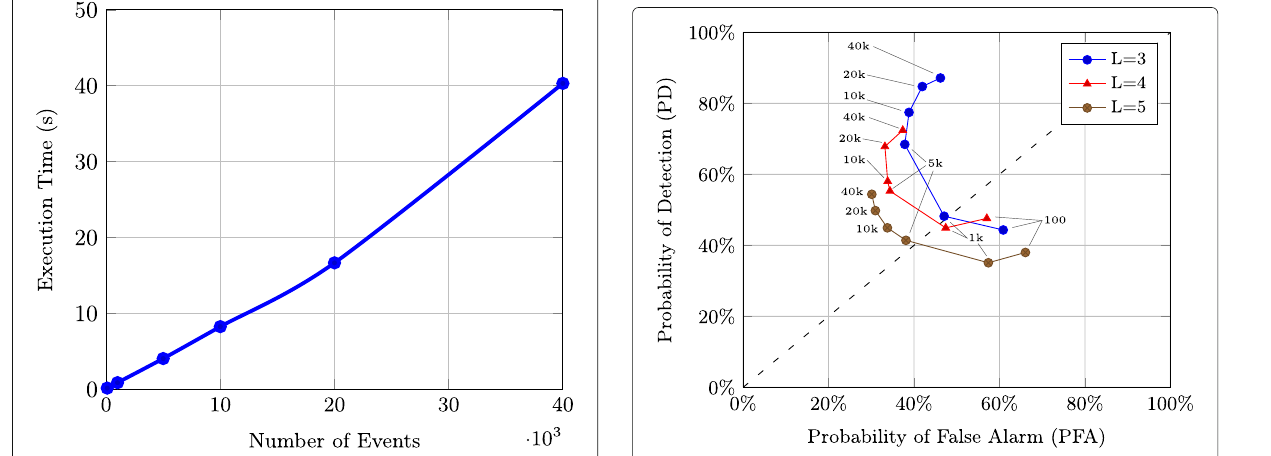
Fig. 13 ROC curve (PFA vs. PD) representing the results from simulations of Morwilog without doing the pheromone update. Conditions are the same as in Fig.